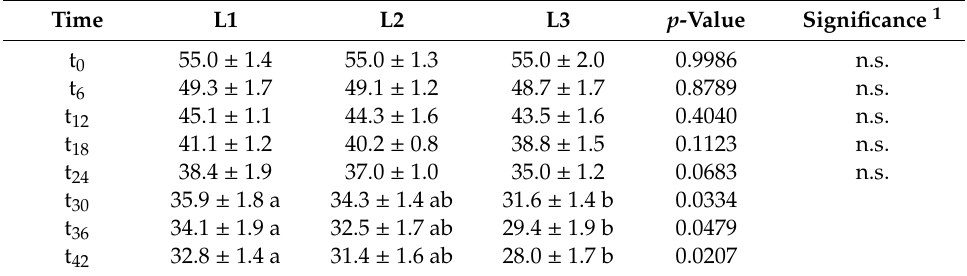
Table 7. Analysis of variance results on moisture content values every six hours (MC) for laurel dehydration process in the three tests (L1 = 3 kg / m 2 ; L2 = 4 kg / m 2 and L3 = 5 kg / m 2 ). Data are means ± SD (n = 3). Values in each row with di ff erent letters are significantly di ff erent from one another at p < 0.05 (Tukey’s